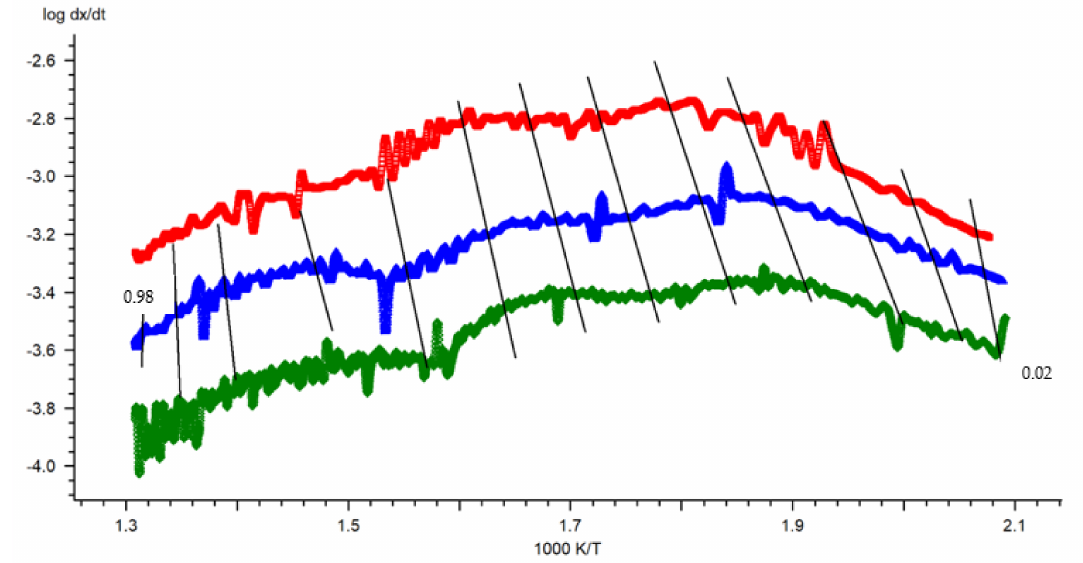
Figure A4. Plot of logarithm dx/dt as a function of reciprocal of temperature by Friedman method for sewage sludge. Red line represents 20 K/min, blue line is 10 K/min and green line is 5